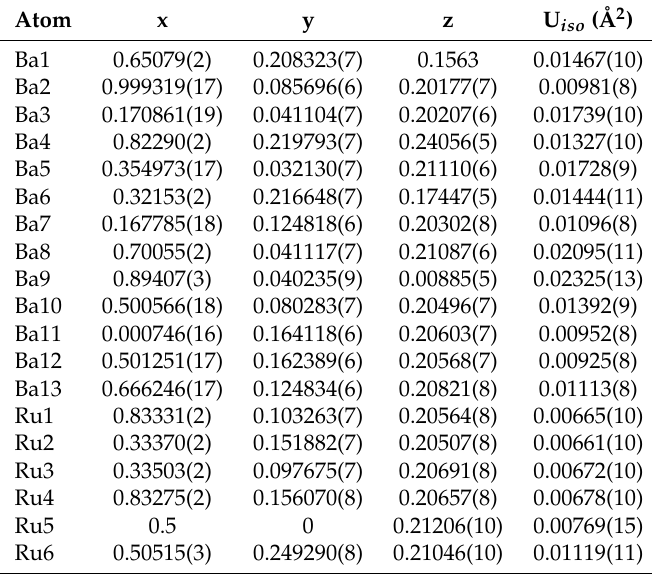
Table 2. Refinement results of single crystal X-ray diffraction measurements of Ba 26 Ru 12 O 57 of the refinement with space group Fdd2 ( a = 20.4638(12) Å, b = 51.191(3) Å, c = 11.7698(7)